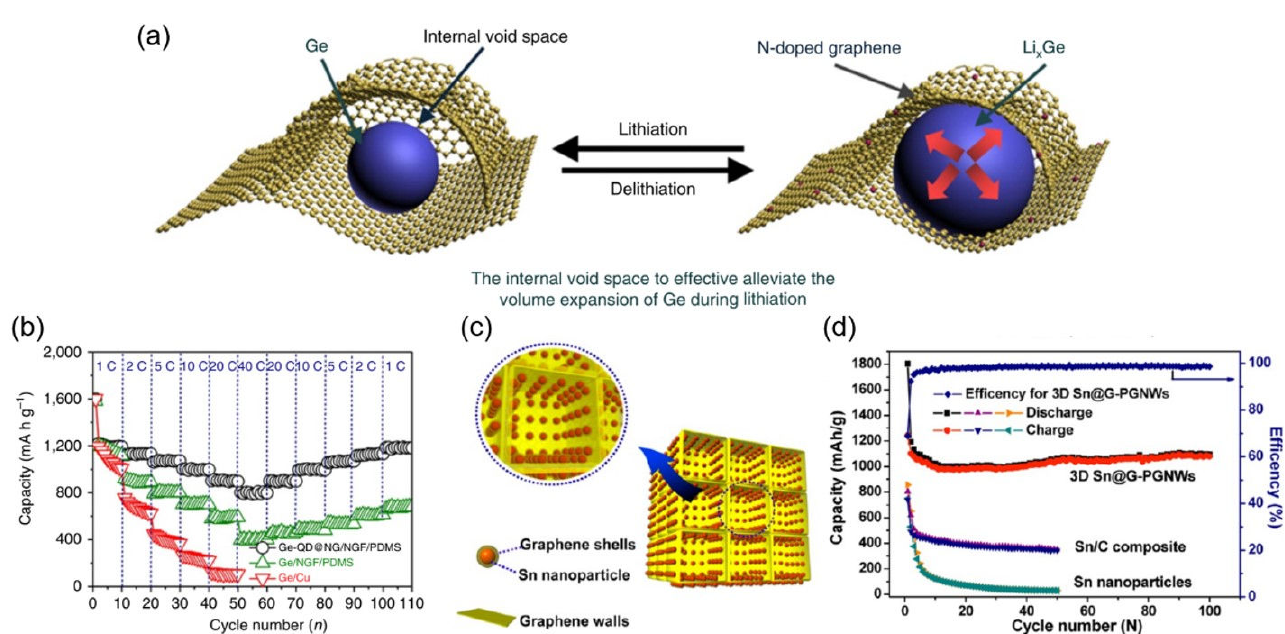
Figure 6. ( a ) Schematic drawing of the lithiation/delithiation process of the graphene–Ge yolk–shell composite anode material. ( b ) Rate performance of the graphene–Ge yolk–shell composite anode material. Reproduced with permission from ref. [60]. Copyright 2017, Nature Publishing Group. ( c ) Schematic drawing of the graphene–Sn composite anode material in the 3D graphene network. ( d ) Cycle performance of the graphene–Sn composite anode material in the 3D graphene network. Reproduced with permission from ref. [64]. Copyright 2014, ACS